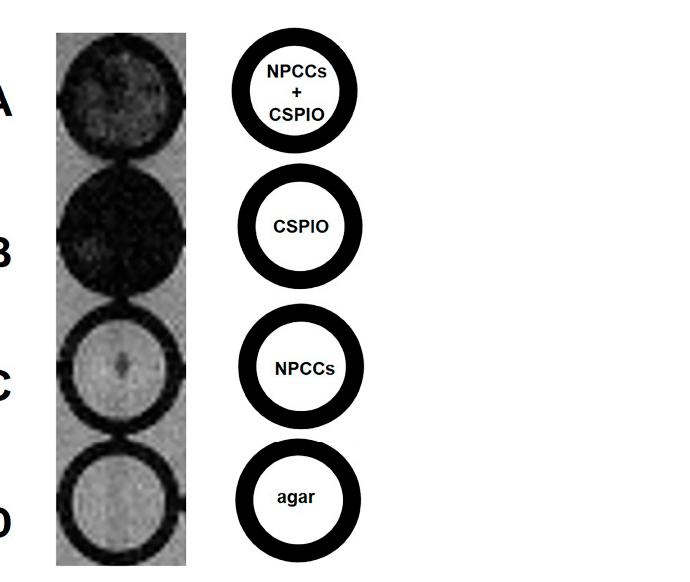
tracellular iron content was examined by Prussian blue staining.